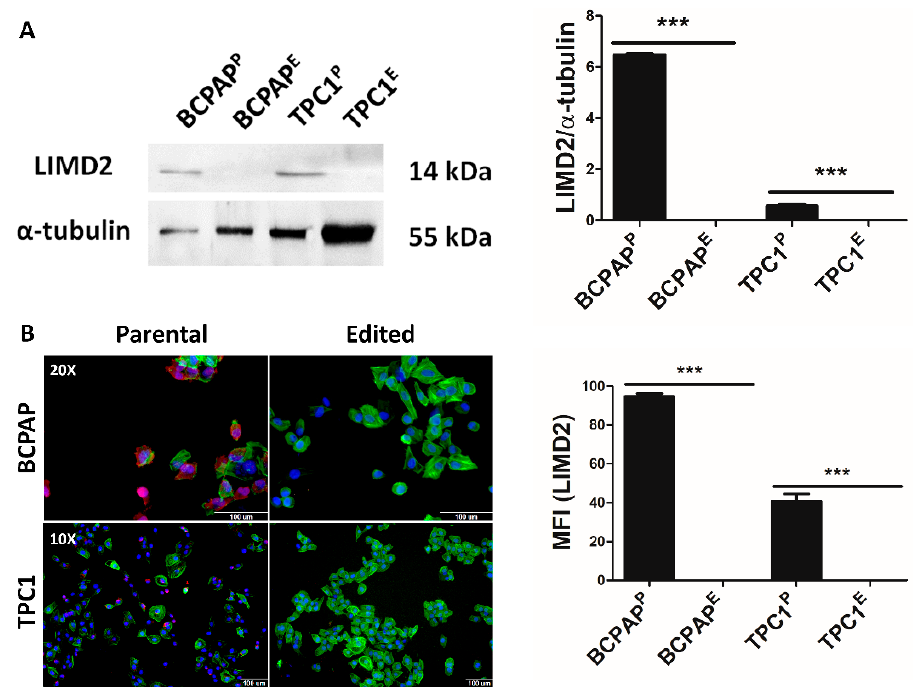
Figure 3. CRISPR / Cas9 promoted complete knockout (KO) of LIMD2 protein. ( A ) Representative Western blot images and graphic representation for LIMD2 shows complete KO in edited cells (BCPAP E and TPC1 E ), while it is expressed in parental or untreated cells (BCPAP P and TPC1 P ). Each column represents the mean ± SD of three experiments performed in triplicate; ( B ) Representative images of the high-content screening analysis and graphic representation confirmed the absence of LIMD2 (pink) expression in both cell line. Green, phalloidin-labeled F-actin and blue, nucleus. Scale bar of 100 µm. MFI, medium of fluorescence intensity. *** p < 0.001.